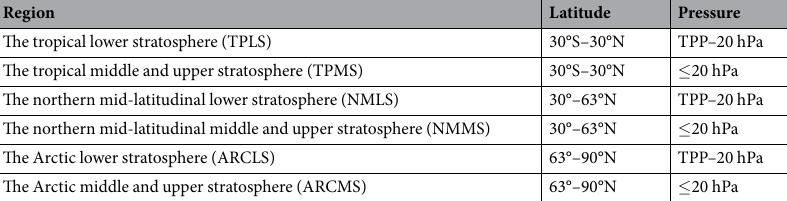
Table 1. The six ozone source regions defined in this study. TPP is an abbreviation for pressure at the tropopause, which is dynamically calculated in the SD-WACCM instead of using fixed pressures. The rest of the atmosphere is denoted as REST.